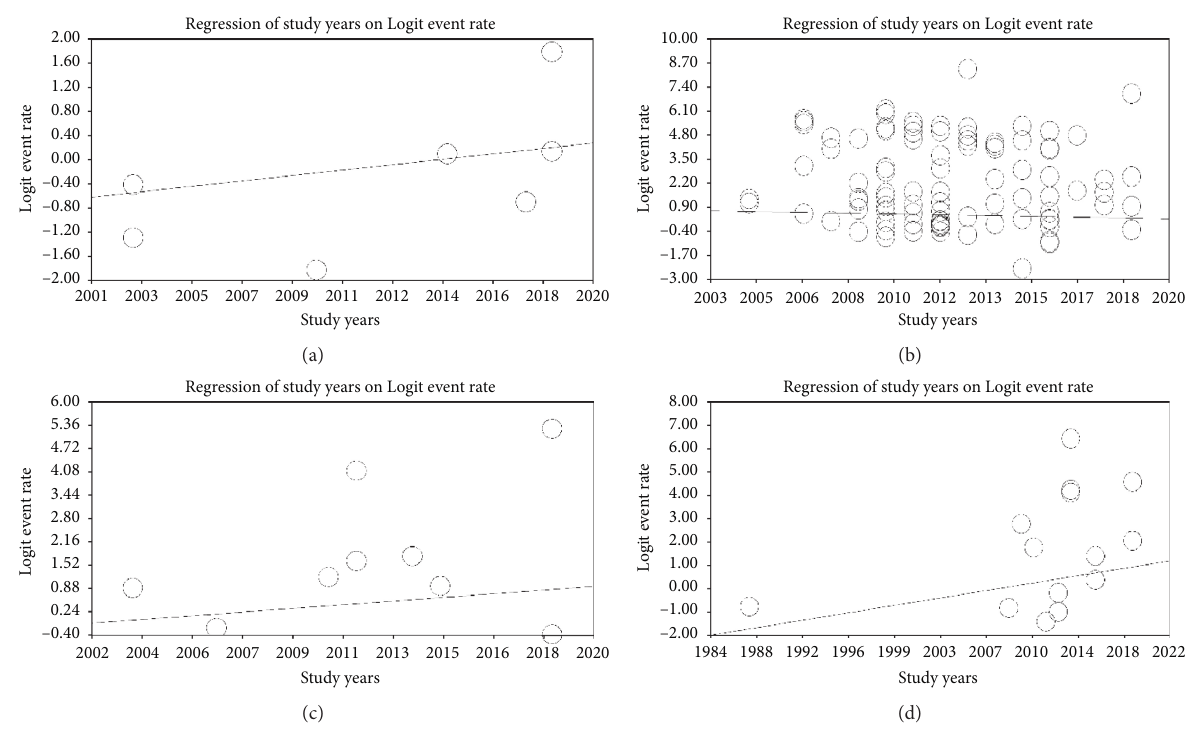
Figure 7: Metaregression of the relationship between the study year and the prevalence of aflatoxin M1 in milk according to the continents